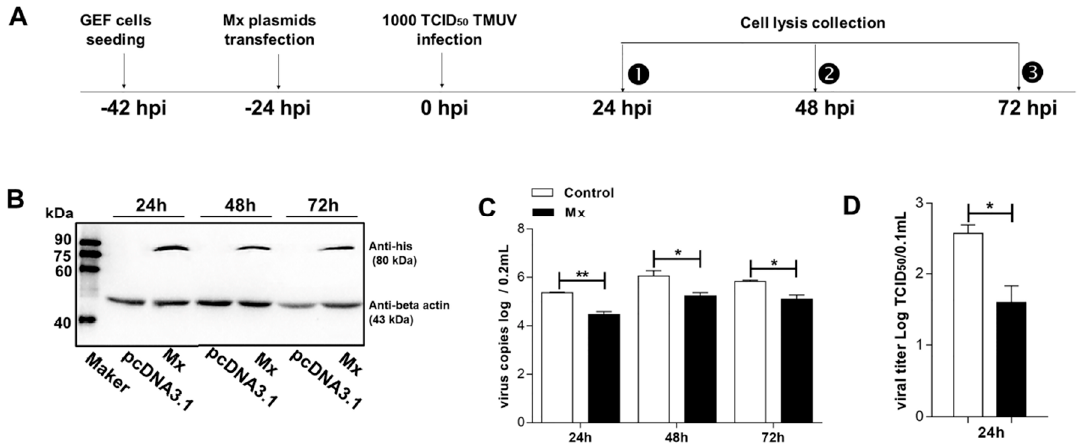
Figure 4. The antiviral activity of goMx. ( A ) Experimental procedure of the antiviral test. ( B ) Detection of goMx protein by western blot analysis. Cell extracts were prepared, and samples of 15 µ L of protein per lane were separated by SDS-polyacrylamide gel electrophoresis. GoMx protein was detected with a His-tagged monoclonal antibody. ( C ) Inhibition of TMUV genomic RNA by goMx in GEF. At 24, 48, and 72 h post-infection (hpi), infected GEF were collected and lysed in 500 µ L cell culture supernatants. Total RNA was extracted using 200 µ L cell lysis and RT-qPCR was performed in triplicate. Data are shown as mean ± SD of three independent experiments (** p < 0.01, * p < 0.5). ( D ) TCID 50 test. The infectious titers from culture supernatants were titrated using the TCID 50 test from control GEF and goMx-expressing cells. The results showed the differences between both groups were significant at 24 hpi. Data are expressed as the mean ± SD of three independent